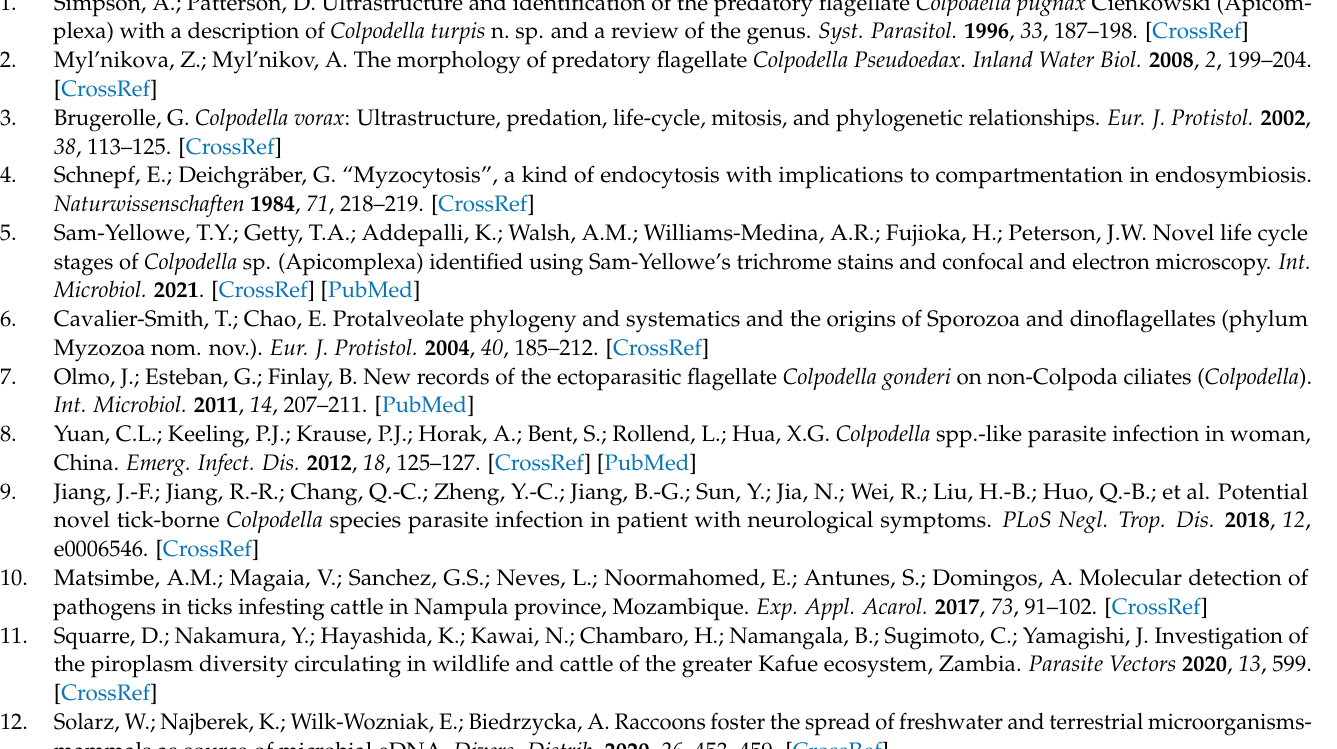
the cytoplasm of P. caudatus were identified. Supplementary Table S1: Summary of time course Table S2. Time Course two observations during the most active parts of the Colpodella sp. (ATCC 50594) life cycle. Time point numbers correspond to hours/days cells were collected for staining. Table S3. Summary of isolation and culture conditions for colpodellids and